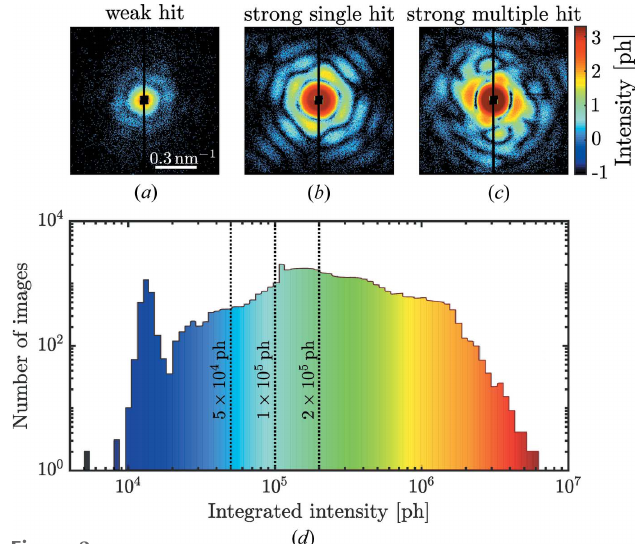
Figure 2 ( a )–( c ) Typical diffraction patterns collected during the SPI experiment with ( a ) typical candidates for weak single hits, ( b ) strong single hits and ( c ) multiple hits (all diffraction patterns are shown on a logarithmic scale). ( d ) Histogram of diffraction images as a function of the integrated intensity. Three dashed threshold lines mark the transient region between weak and strong hits passing our intensity filter. Diffraction patterns in ( a ) and ( c ) belong to blue and red regions in ( d ), respectively. The diffraction pattern in ( b ) belongs to the central region in ( d